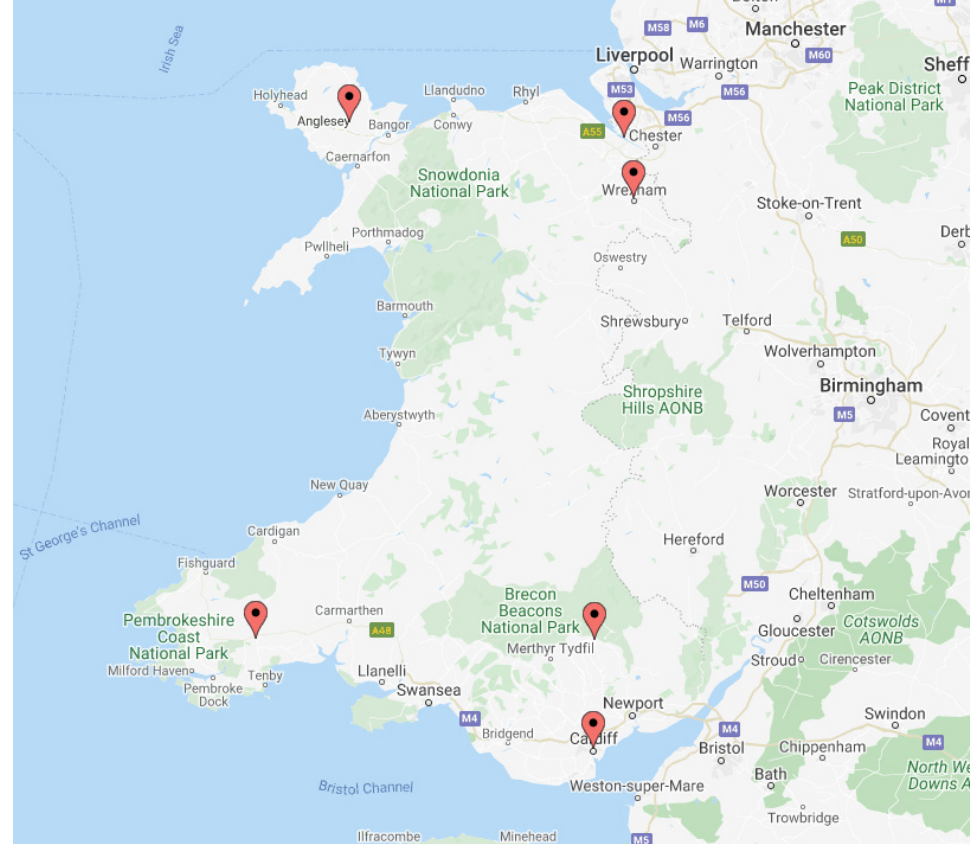
Figure 1. Locations in Wales, clockwise from the top left . [Llangefni, Shotton, Wrexham, Brynmawr, Cardiff, and Narberth].